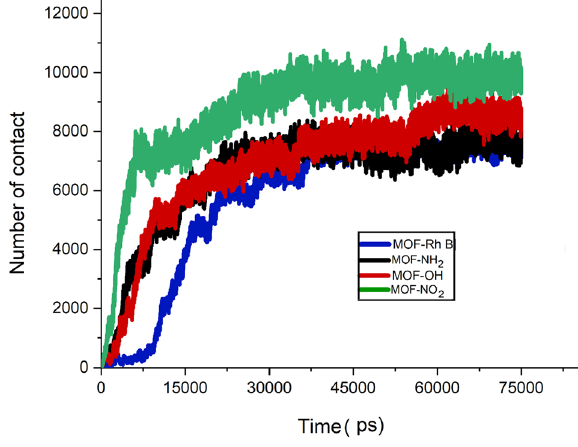
Fig. 6 The variations of the number of contacts between the guest molecules and the MOF (blue), MOF-NH2 (black), MOF-OH (red), and MOF-NO2 (green)